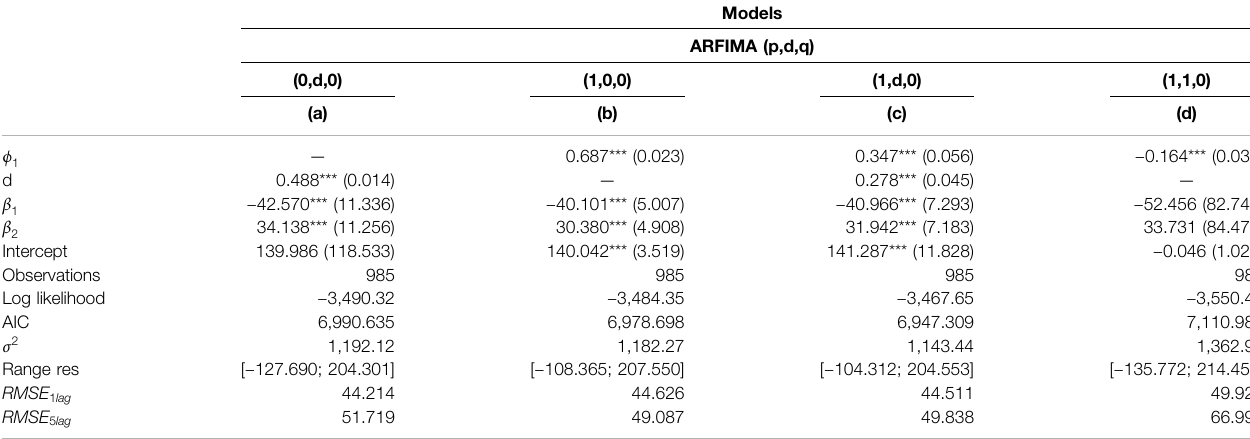
TABLE 1 | Estimates of ARFIMA models with different orders where the response variable is the average daily radon measurements in Figure 1 .